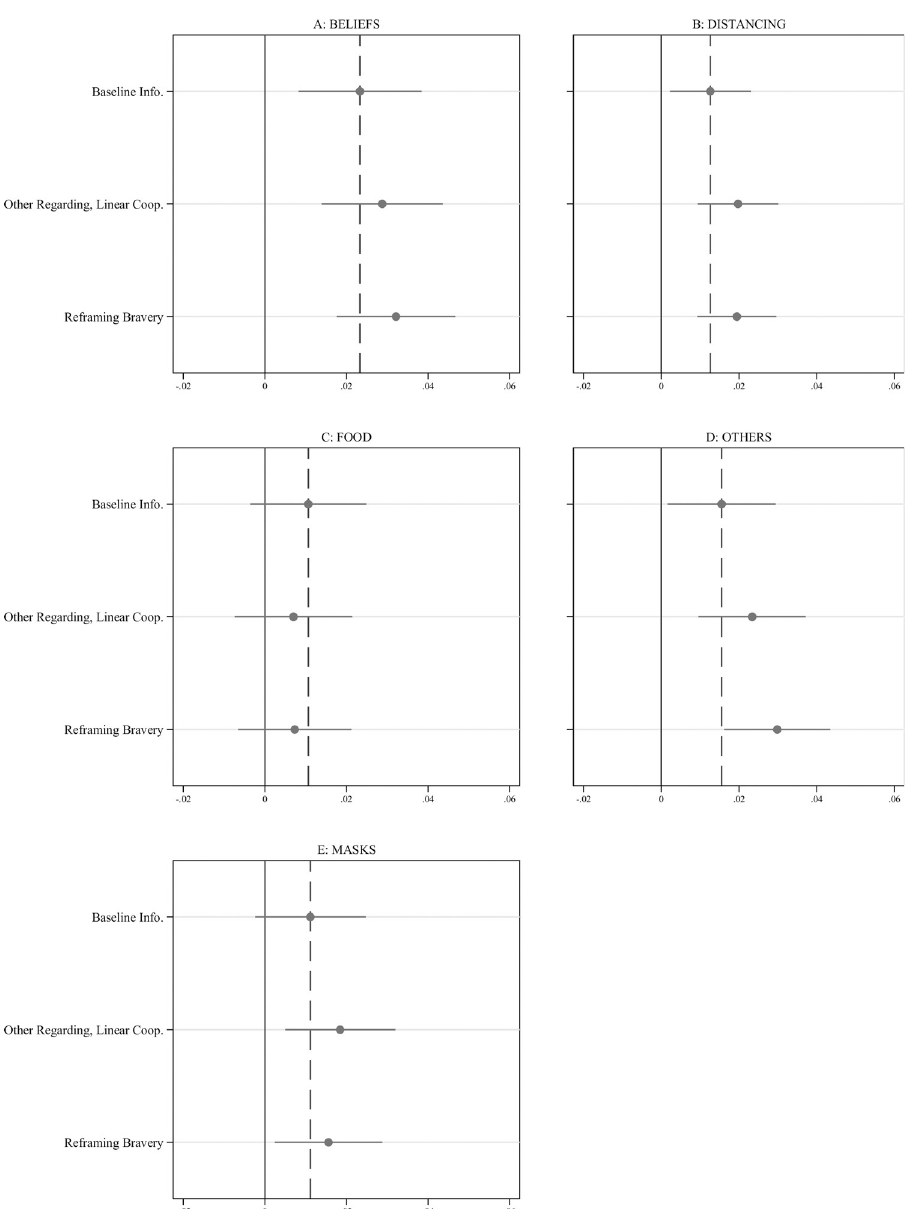
Fig 2. Experiment 2 results. Compared to the placebo control, the Baseline Informational message, the Reframing Bravery message, and the Other-regarding, Linear Cooperation increase beliefs and reported behavioral intentions to practice social distancing. These are OLS regression coefficient estimates for each primary outcome by treatment compared to the placebo control with 90% confidence intervals. The dashed vertical line represents the effect of the Baseline Informational Message on an outcome. All outcomes scales were coded such that higher values indicate more positive attitudes or intentions toward social